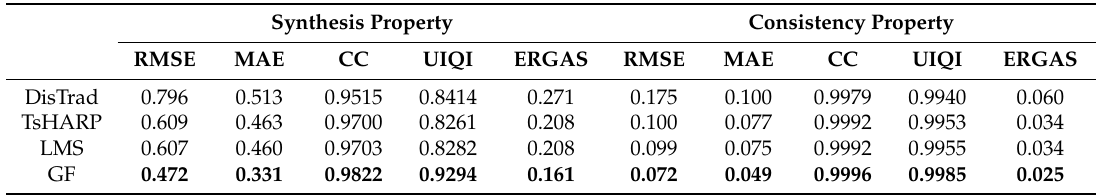
Table 2. Results of quantitative image quality assessment corresponding to each disaggregation algorithm. The optimal values in terms of quality index are highlighted in